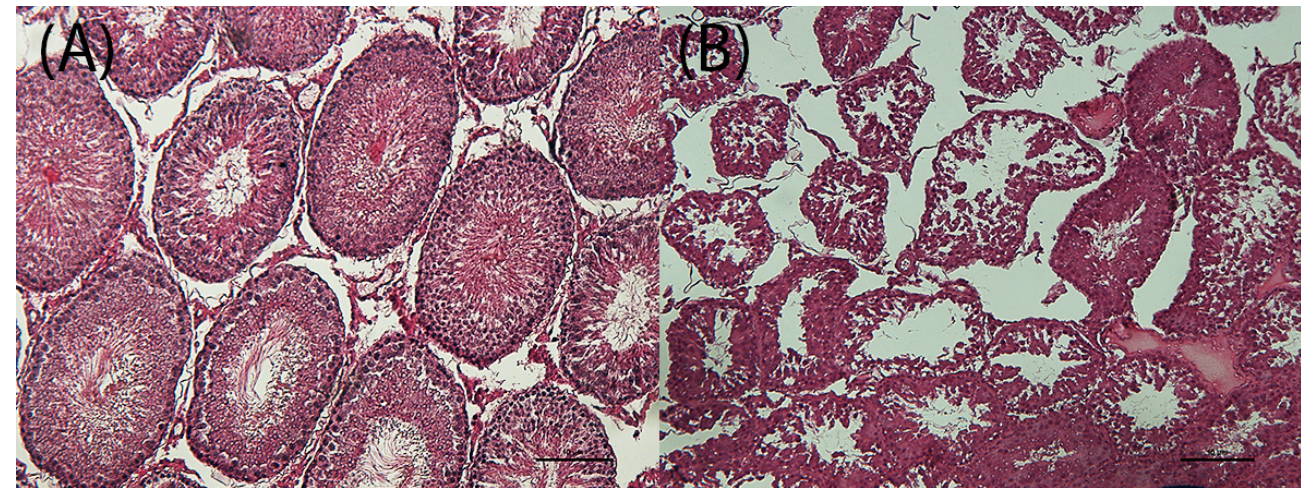
Figure 6. Testes of male rats subcutaneously treated five times a week, for 2 weeks with 0 — sesame oil Panel ( A ) and 0.18 + 0.33 mg of estradiol valerate plus cyproterone acetate Panel ( B ). Tubule degeneration with germinal epithelium degeneration. Bar 10 µ m (original magnification 10 × ; haematoxylin and eosin stain).